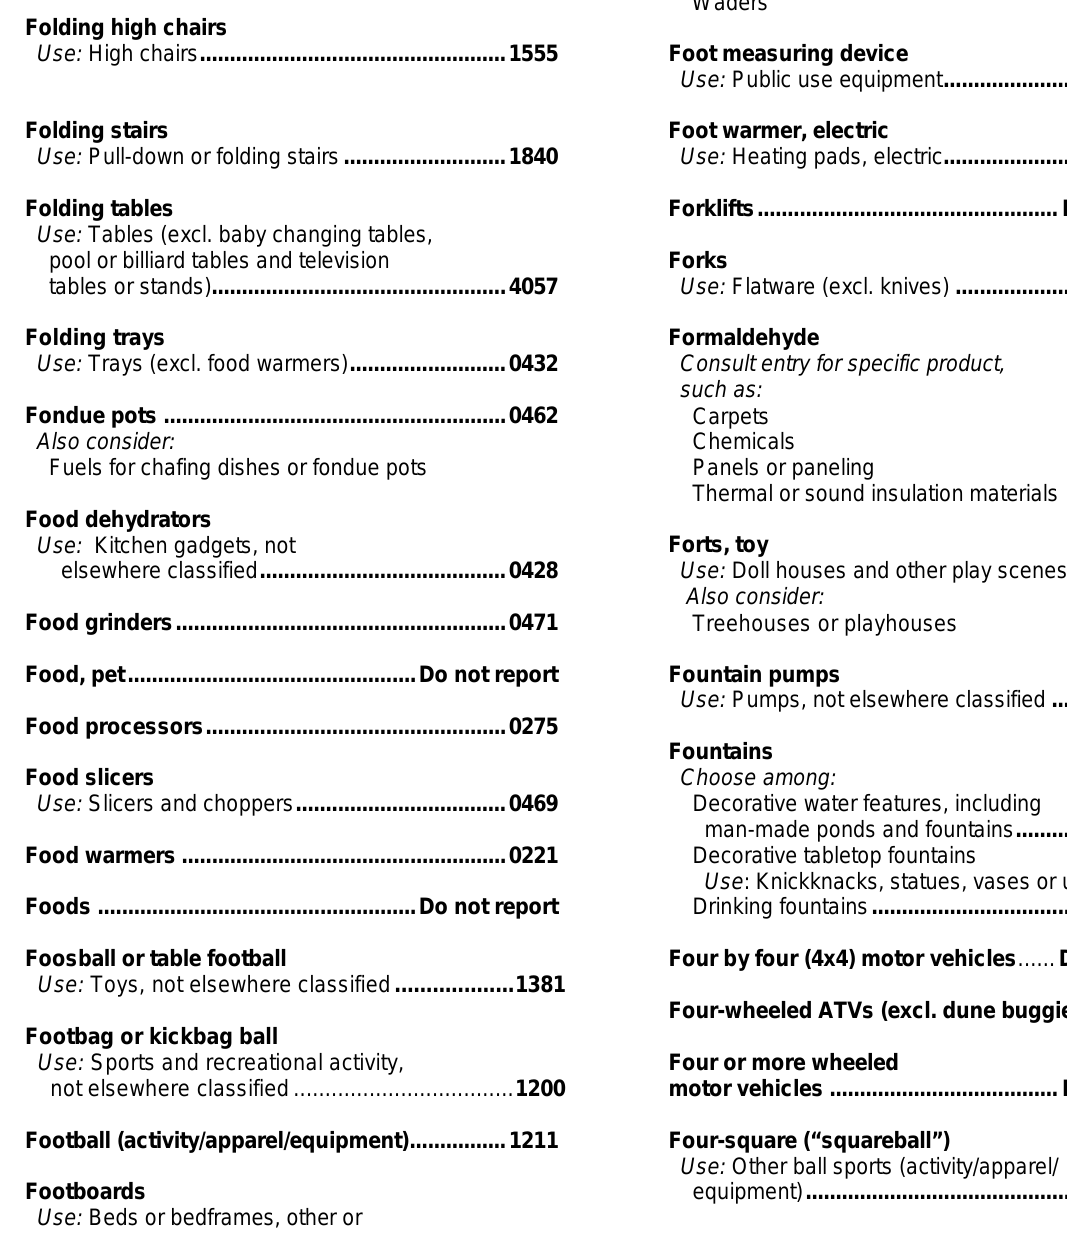
Footboards Use: Beds or bedframes, other